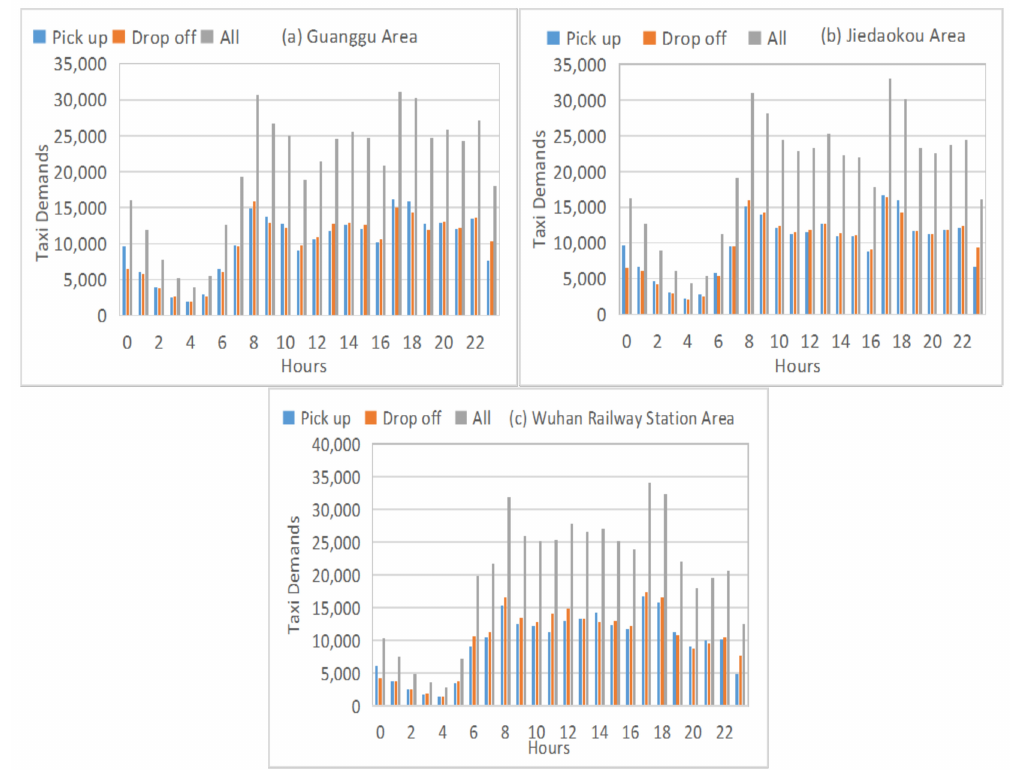
Figure 8. Taxi demands distribution in the city of Wuhan during daily hours.